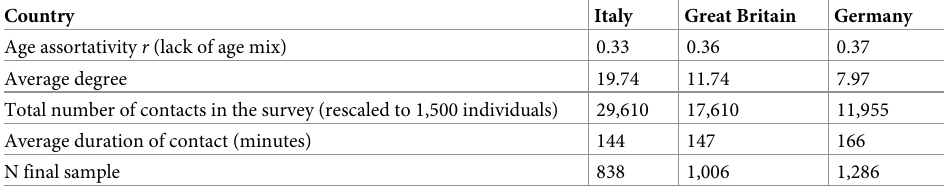
Table 1. Descriptive statistics of contacts declared by nationals of three